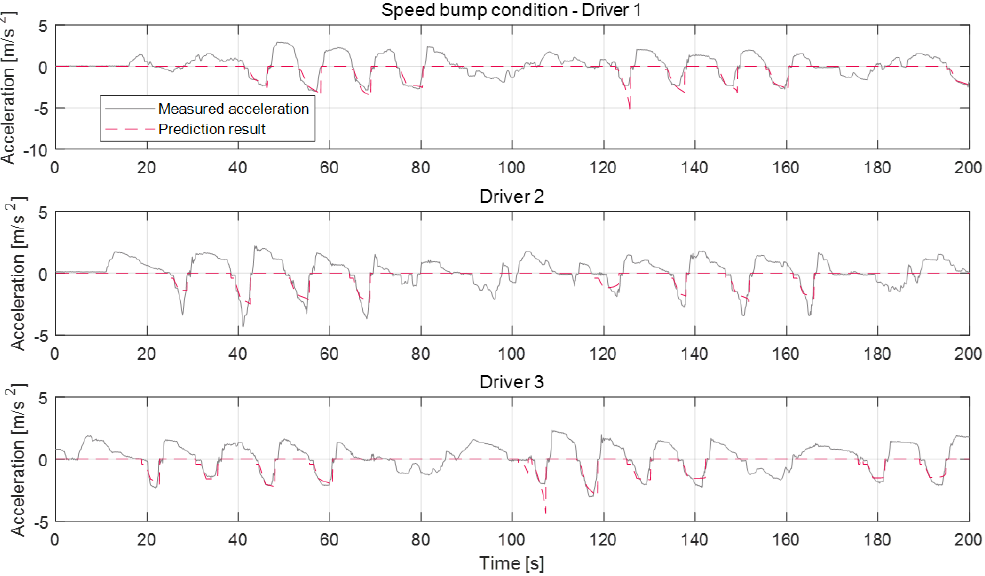
Figure 18. Deceleration prediction results on speed bump condition.